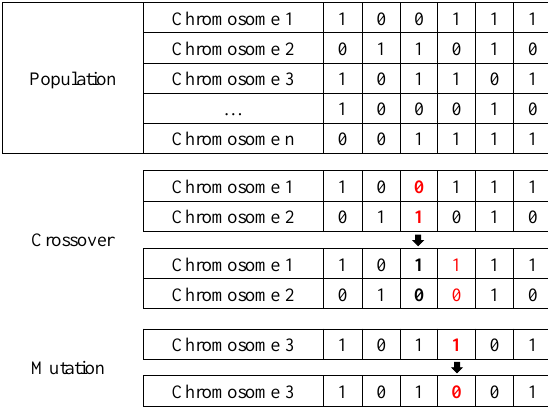
Figure 2. Illustration of the GA operators